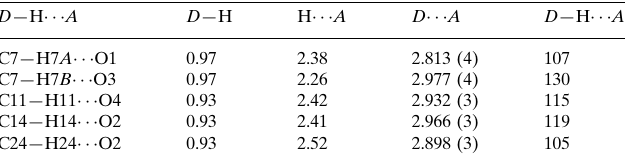
Related literature